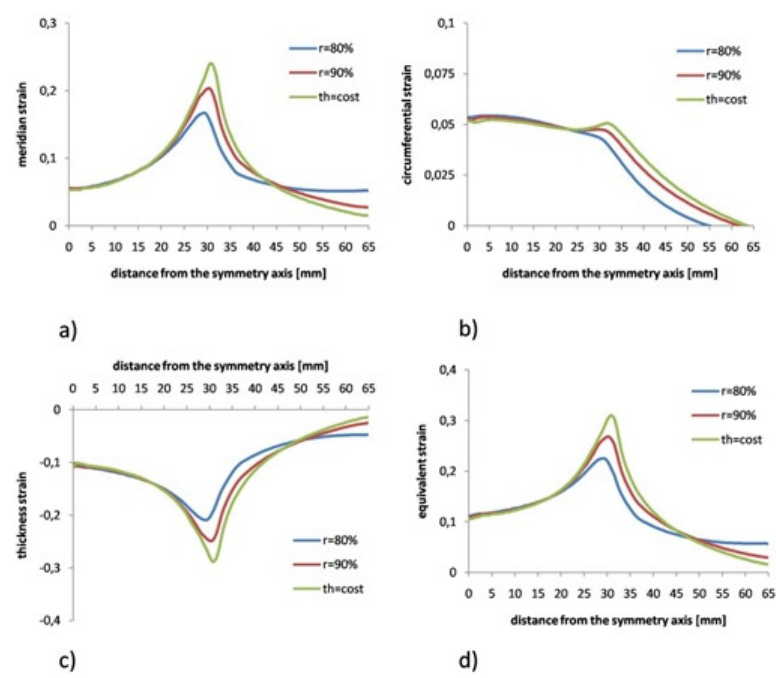
Figure 8. Comparison between the main strains and the equivalent strain during the stretching process on a constant (th = cost) and a variable (r = 80% e r = 90%) thickness sheet in friction conditions with a friction coefficient μ = 0.2 due to FEM: ( a ) meridian strain; ( b ) circumferential strain; ( c ) thickness strain; ( d ) equivalent strain.